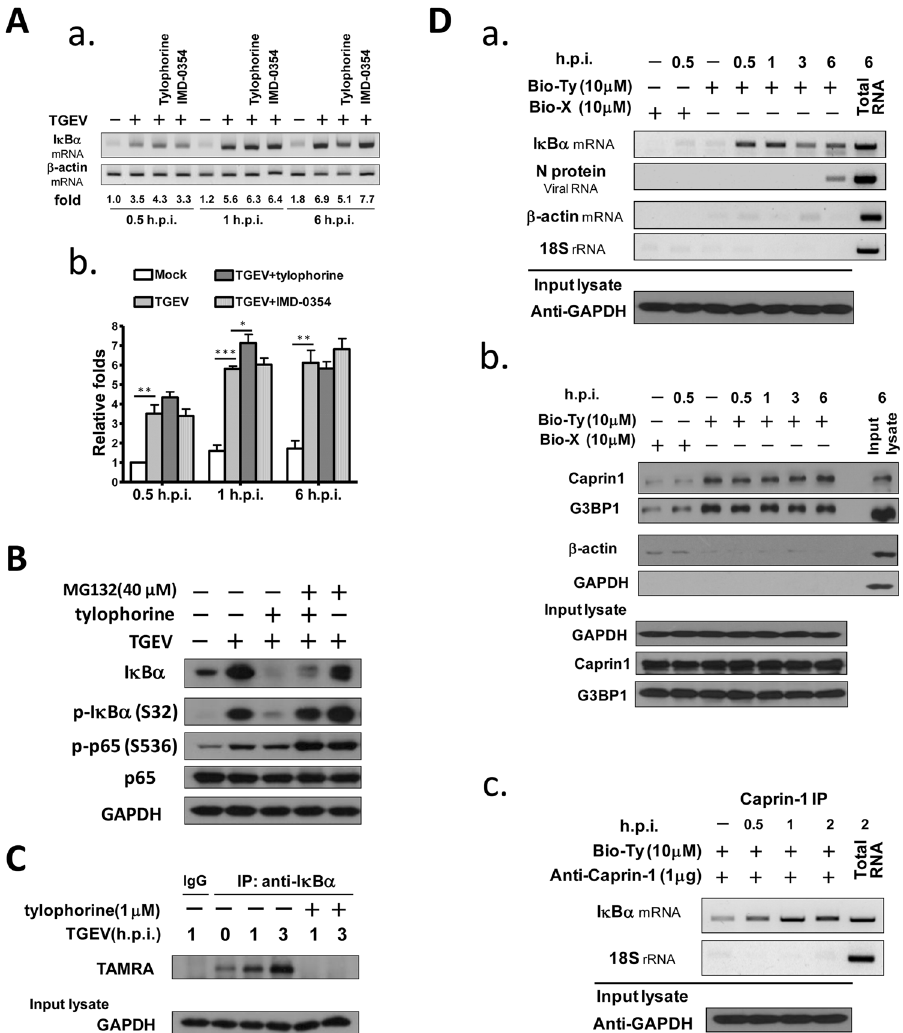
Figure 5. Tylophorine suppressed de novo protein synthesis of I κ B α by arresting I κ B α mRNA associated ribonucleioprotein complex for translational inhibition. ( A ) Effect of tylophorine on the induction of I κ B α mRNA levels. ST cells were pretreated with tylophorine (1 µ M) or IMD-0354 (30 µ M) for 1 h prior to TGEV infection with the time period indicated. The relative levels of I κ B α mRNA were normalized with the control β -actin. ( B ) Tylophorine diminished I κ B α protein levels which were independent of proteolysis. ST cells were pretreated with MG132 for 1 h and then followed by tylophorine treatment for another 1 h prior to TGEV infection. Cells were harvested at 1 h.p.i. of TGEV infection and the resultant lysates subjected to western analysis with the antibodies indicated. ( C ) Tylophorine inhibited I κ B α de novo protein synthesis. The TGEV infected ST cells, co-cultured with Click-iT ® HPG, were harvested and subjected to immunoprecipitation by an anti-I κ B α followed by western analysis with an antibody against TAMRA for newly synthesized I κ B α . ( D ) Tylophorine was associated with the RNP complex of I κ B α mRNA and caprin-1 protein. Biotinylated tylophorine interacted with I κ B α mRNA (a) and capriin-1 protein (b). I κ B α mRNA was co- immunoprecipitated with anti-caprin-1 (c). ST cells were infected with TGEV and harvested at the indicated h.p.i. for preparation of lysates for pull-down experiments (a and b). The resultant total lysates (600 µ g) were incubated with 10 µ M of biotinylated tylophorine or Biotin-X-SSE for 4 h and the pulled down mRNA complexes, after TRIzol extraction, were subjected to RT-PCR with the indicated specific primer pairs (a) or the pulled down proteins were subjected to western analysis with the indicated antibodies for caprin-1 and G3BP1 (b). Or, the infected ST lysates were incubated with an antibody against caprin-1 in the presence of biotinylated tylophorine and the immunoprecipitates were subjected for mRNA isolation and subsequent RT-PCR for analysis of relative I κ B α mRNA or 18 S rRNA levels (c). Biotinylated tylophorine: Bio-Ty; Biotin- X-SSE: Bio-X. Results shown are representative of three independent experiments or means ± S.D. of three independent experiments. ( * p < 0.05 & ** p < 0.01 & *** p < 0.001) Uncropped images for Fig. 5 are presented in Supplementary Figure